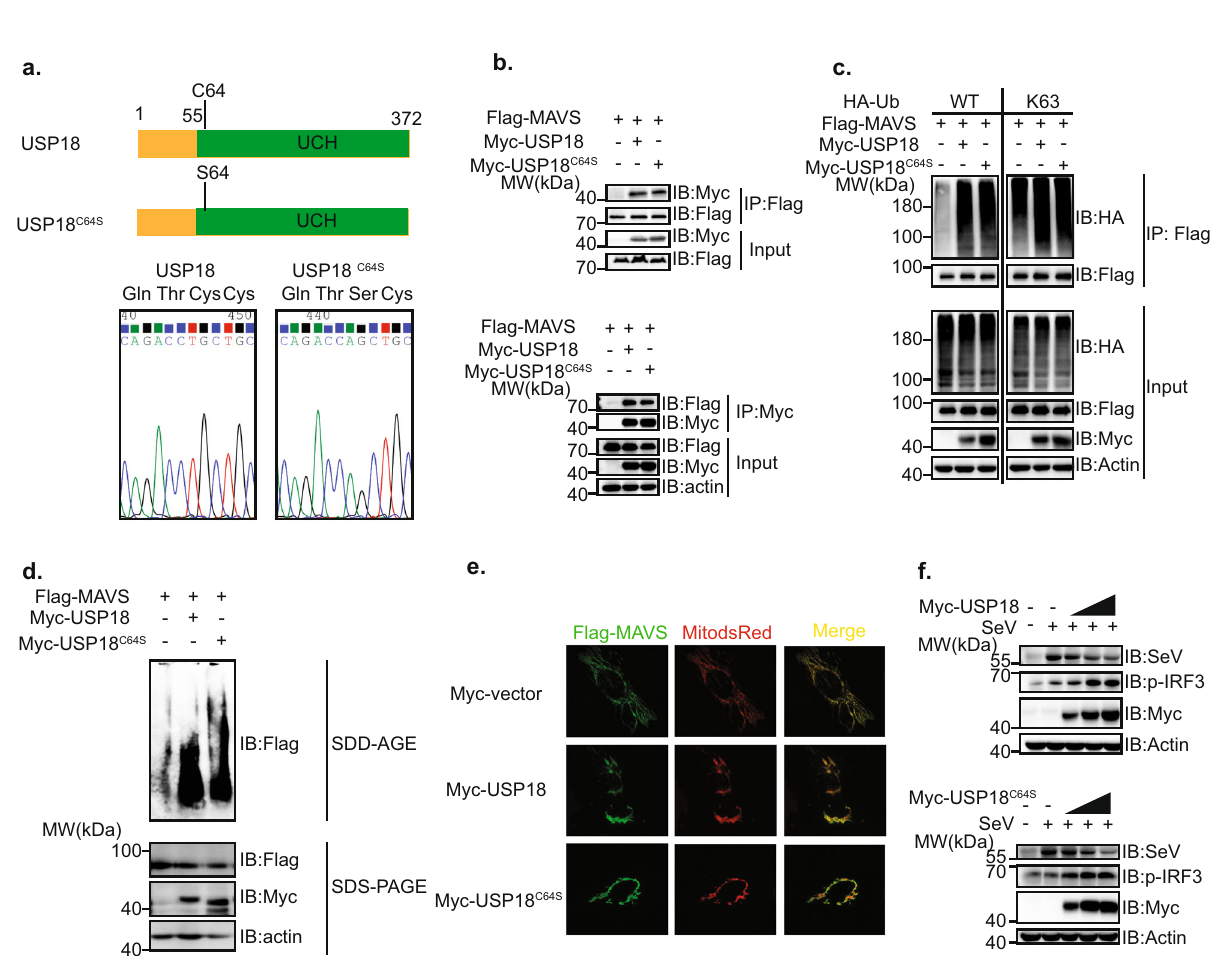
Fig. 5 USP18 promotes the K63-linked polyubiquitination and subsequent aggregation of MAVS. a Immunoprecipitation analysis of ubiquitination of signaling molecules in HEK293T cells transfected with the plasmids expressing Myc-MAVS or STING, HA-Ub, and Flag vector or Flag-USP18. b Immunoprecipitation analysis of ubiquitination of MAVS in HEK293T cells transfected with the plasmids expressing Flag-MAVS, HA-wild-type, K63 only, or K48 only Ub, and Myc vector or Myc-USP18. c Immunoblot analysis of ubiquitination of endogenous MAVS in RAW264.7 cells transfected with siControl or siUSP18 followed by infection with SeV for indicated time points. d K63-Ub-TUBE analysis of ubiquitination of endogenous MAVS in Usp18 + / + and Usp18 − / − MEFs infected with SeV and harvested at indicated time points. e SDD-AGE (top) and SDS-PAGE (bottom) immunoblot analysis of MAVS aggregation in HEK293T cells transfected with the plasmids expressing Flag-MAVS with Myc vector or Myc-USP18. f Representative confocal images of immuno fl uorescence staining for HeLa cells transfected with the plasmids expressing Flag-MAVS, DsRED2-Mito together with Myc vector or Myc-USP18, scale bar, 10 µ m. g Quanti fi cation of MAVS aggregate in HeLa cells transfected with the plasmids expressing Flag-MAVS, DsRED2-Mito together with Myc vector or Myc-USP18 (50 cells per sample). Data are presented with mean ± SD, with ** p = 0.0019 (two-tailed Student ’ s t test). h SDD-AGE (top) and SDS-PAGE (bottom) immunoblot analysis of MAVS aggregation in Usp18 + / + and Usp18 − / − MEFs infected with SeV and harvested at indicated time points. i Representative confocal images of immuno fl uorescence staining for Usp18 + / + and Usp18 − / − MEFs harvested before infection or infection with SeV for 8 h, scale bar, 10 µ m. j Quanti fi cation of MAVS aggregate in Usp18 + / + and Usp18 − / − MEFs harvested before infection or infection with SeV for 8 h (30 cells per sample). Data are presented with mean ± SD, with * p = 0.0328 (two-tailed Student ’ s t test).